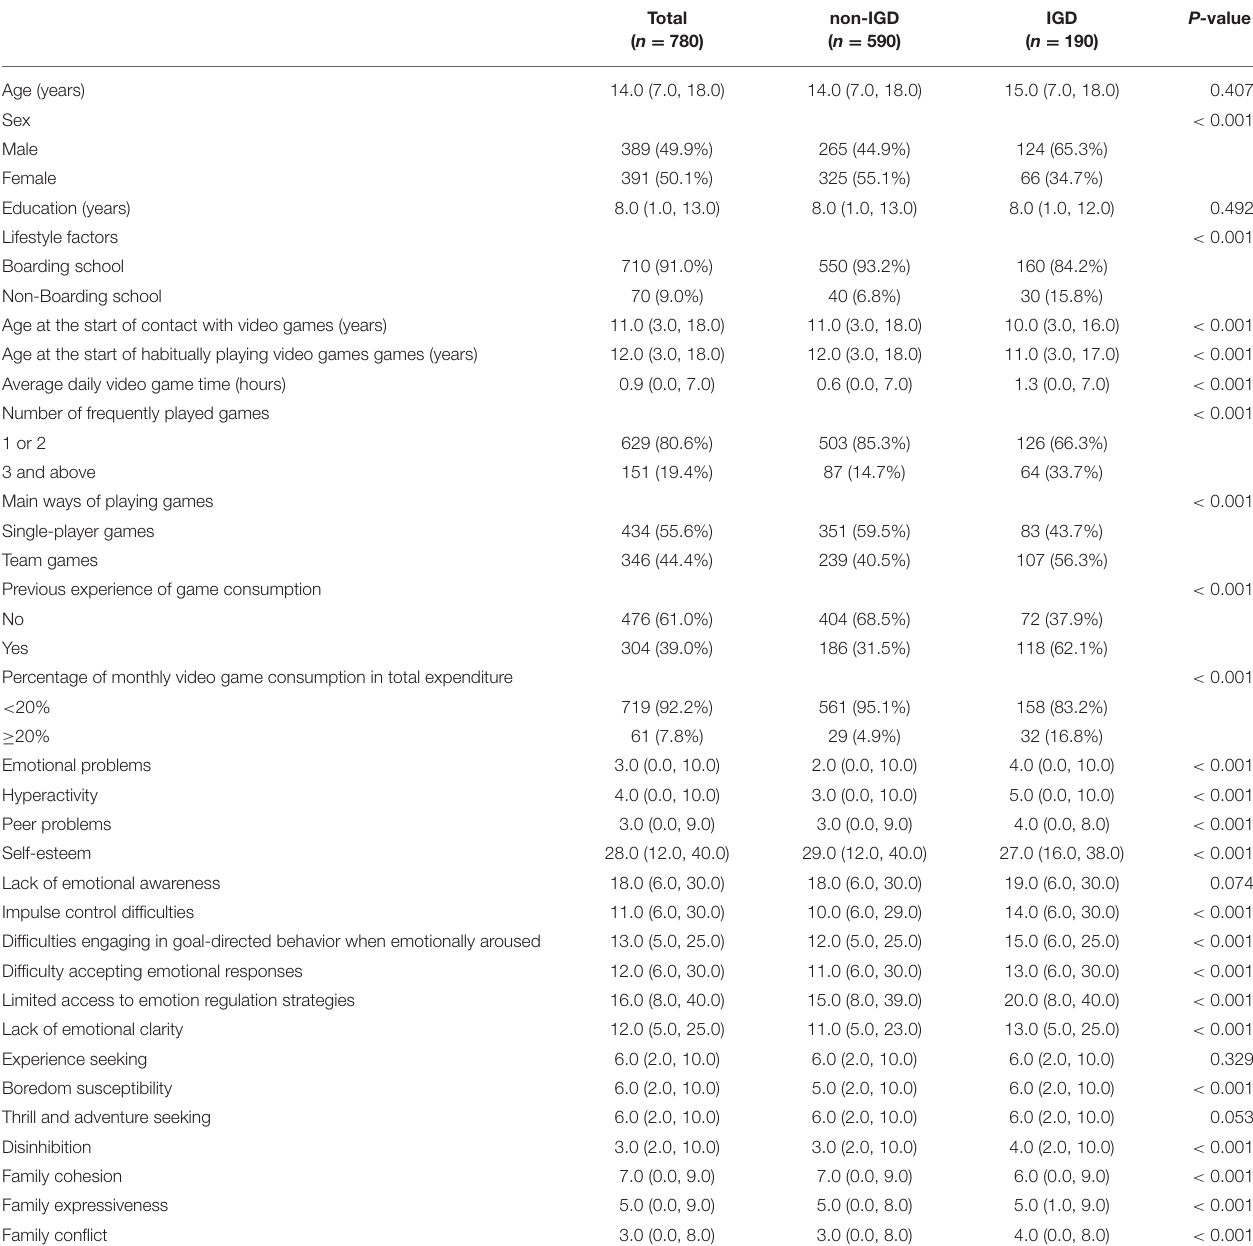
TABLE 1 | Comparison of clinical characteristics between participants with and without IGD [ n (%), median